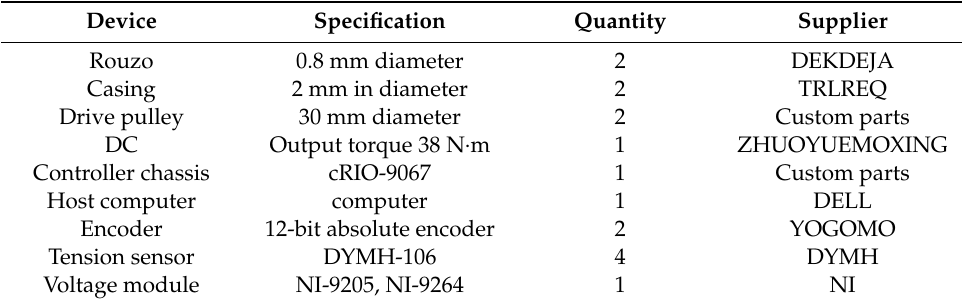
Table 1. The main hardware of the double tendon-sheath transmission experiment system.